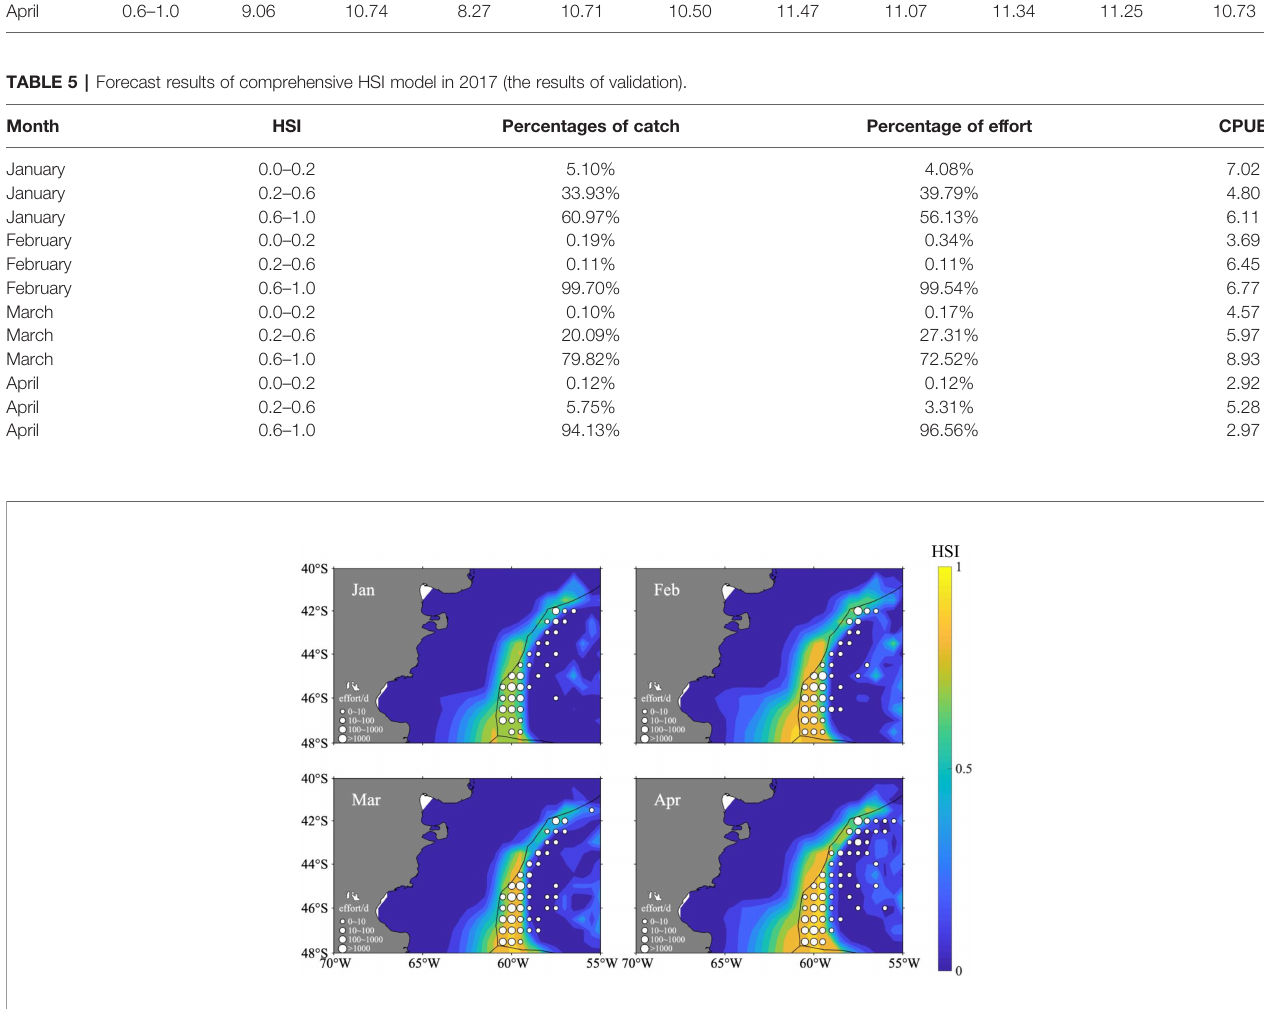
FIGURE 2 | Spatial distribution of HSI overlaid with fi shing effort from 2013 to